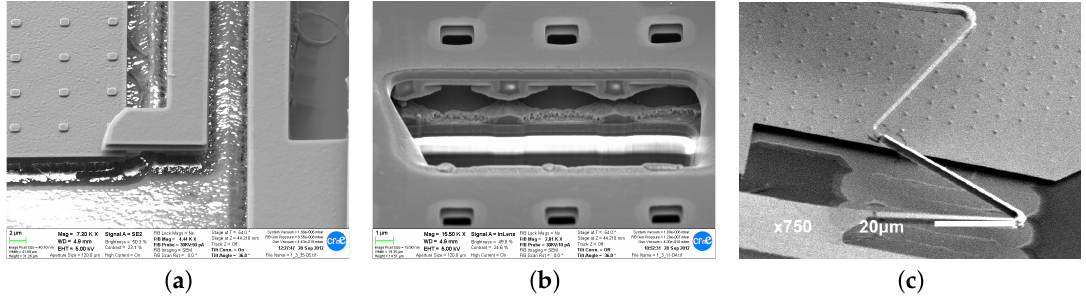
Figure 12. Different implementations of dimples using: MIM ( a ); oxide residues ( b ); and vias ( c ).